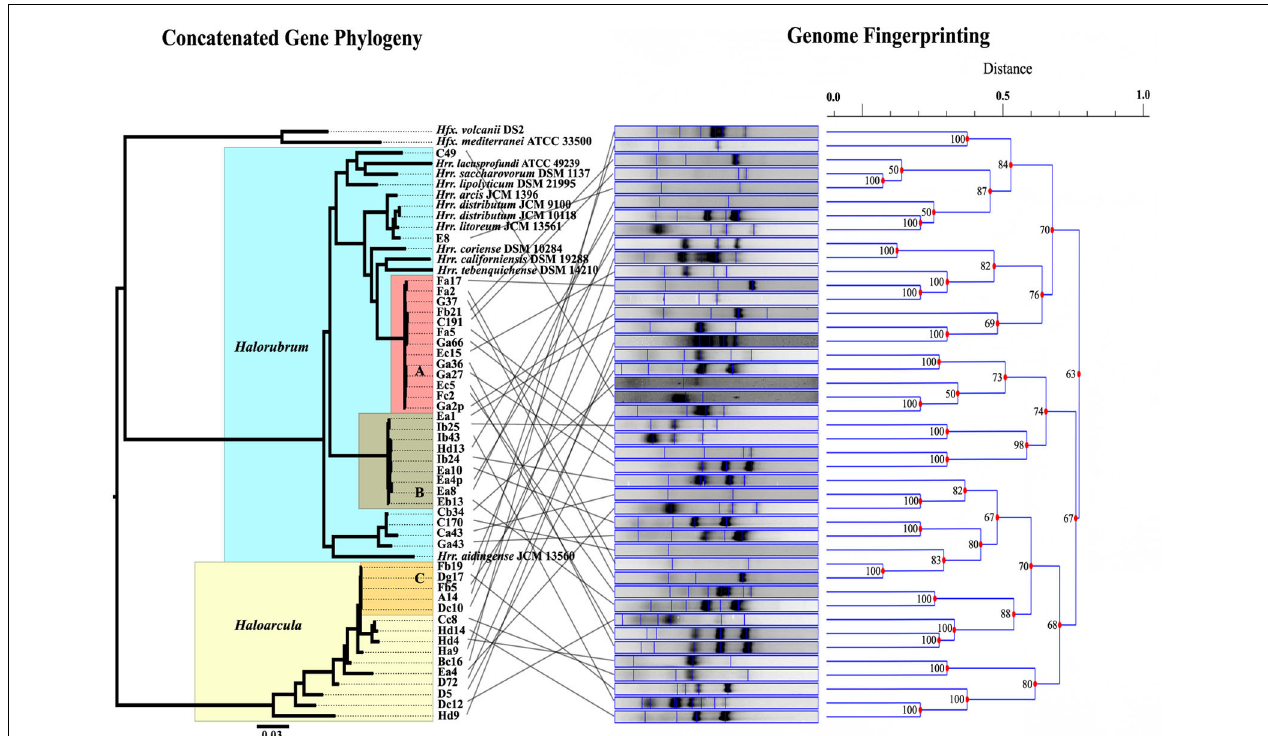
FIGURE 3 | Comparison of the maximum likelihood tree computed from the concatenation of five housekeeping genes, and the UPGMA dendrogram determined from the banding patterns of the genome fingerprinting. Lines between tree and dendrogram connect the same strain in the different analyses.